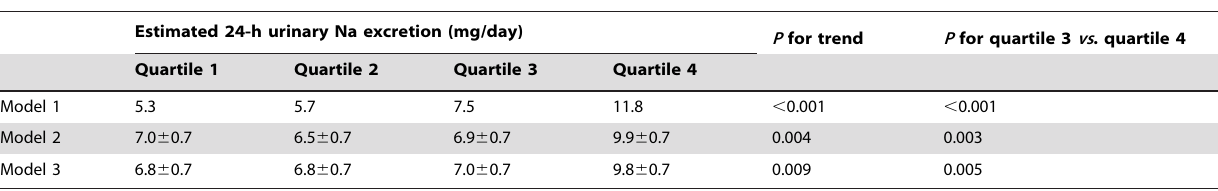
Table 3. Prevalence of albuminuria according to the estimated 24-h urinary Na excretion.